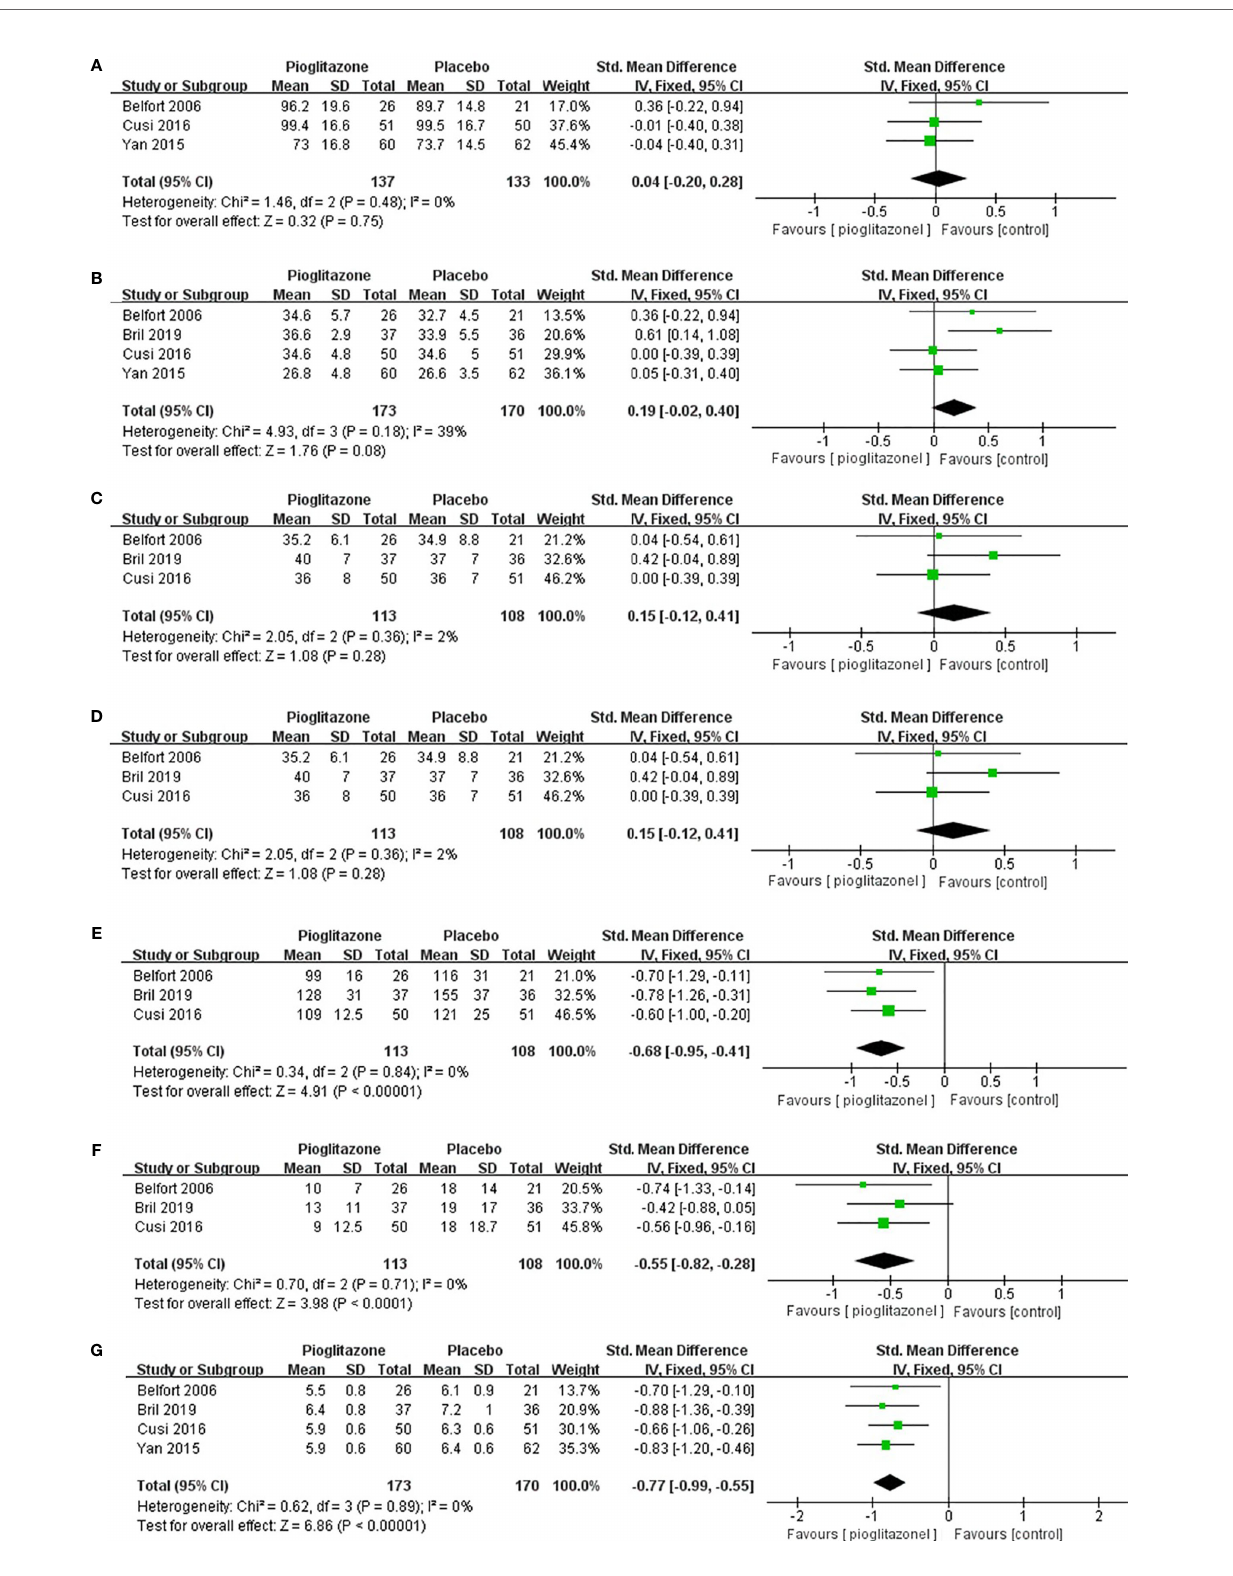
FIGURE 4 | The effect of pioglitazone on weight (A) ; the effect of pioglitazone on BMI (B) ; the effect of pioglitazone on total body fat (C) ; the effect of pioglitazone on HOMA-IR (D) ; the effect of pioglitazone on fasting plasma glucose (E) ; the effect of pioglitazone on fasting plasma insulin (F) ; and the effect of pioglitazone on HbA1c (G)